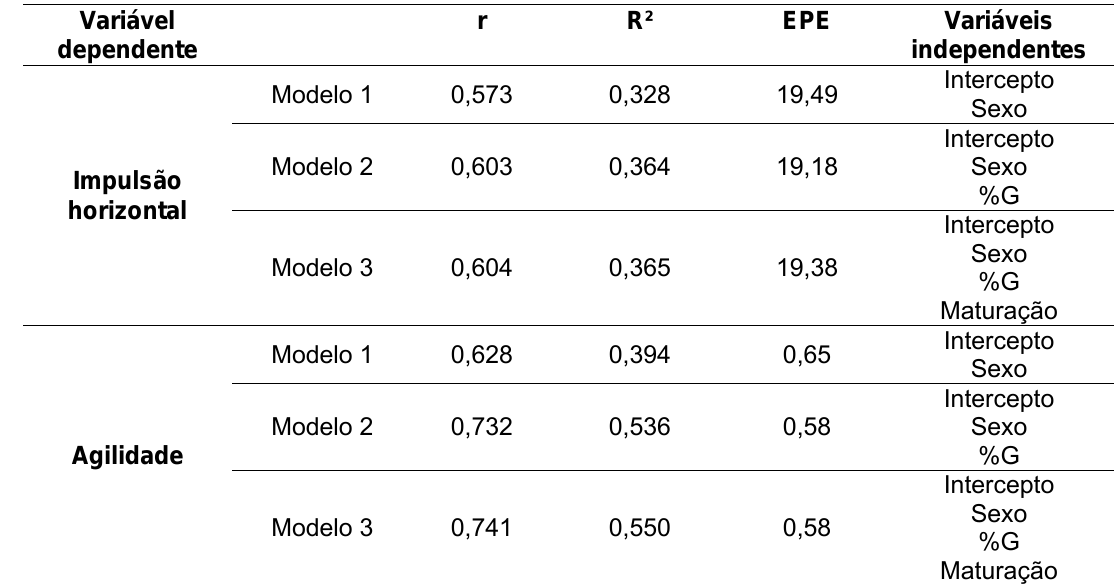
Tabela 4. Modelos de regressão linear para a relação entre o sexo e as variáveis de impulsão horizontal e agilidade, ajustado pelo percentual de gordura e a